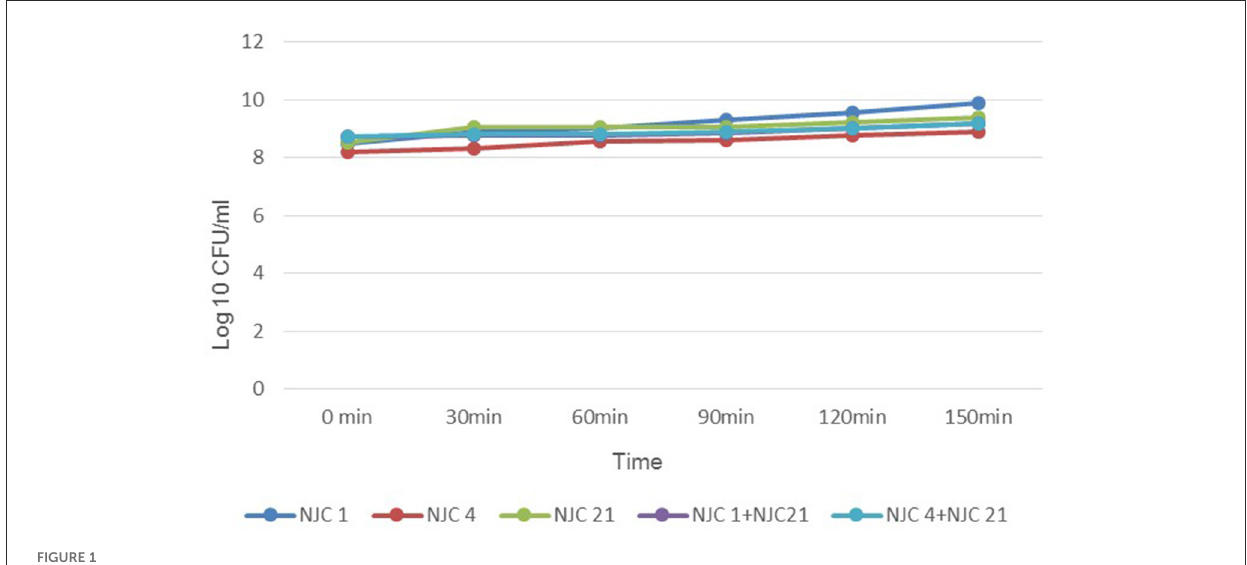
FIGURE1 Growth profiling of isolates and